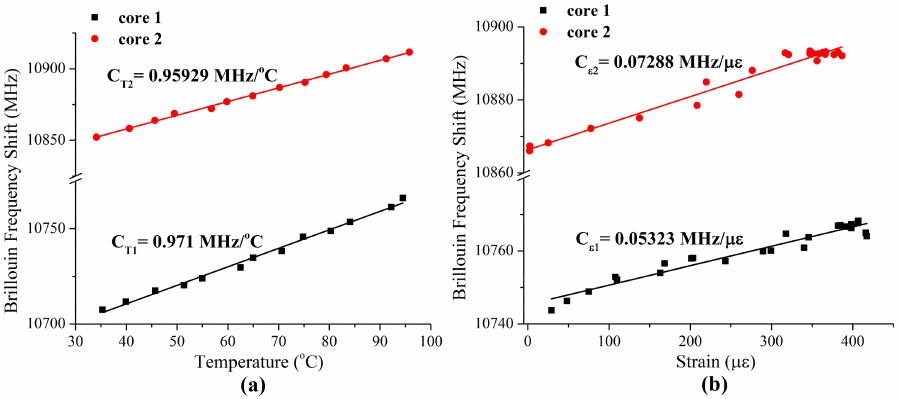
Figure 2. ( a ) Experimental determination of temperature coefficients ( c T ,1 and c T ,2 )—plots and best fit lines of ∆ ν 1 and ∆ ν 2 as a function of ∆ T as described in the text; ( b ) experimental determination of strain coefficients ( c (cid:101) ,1 and c (cid:101) ,2 )—plots and best fit lines of ∆ ν 1 and ∆ ν 2 as a function of ∆ (cid:101) as described in the